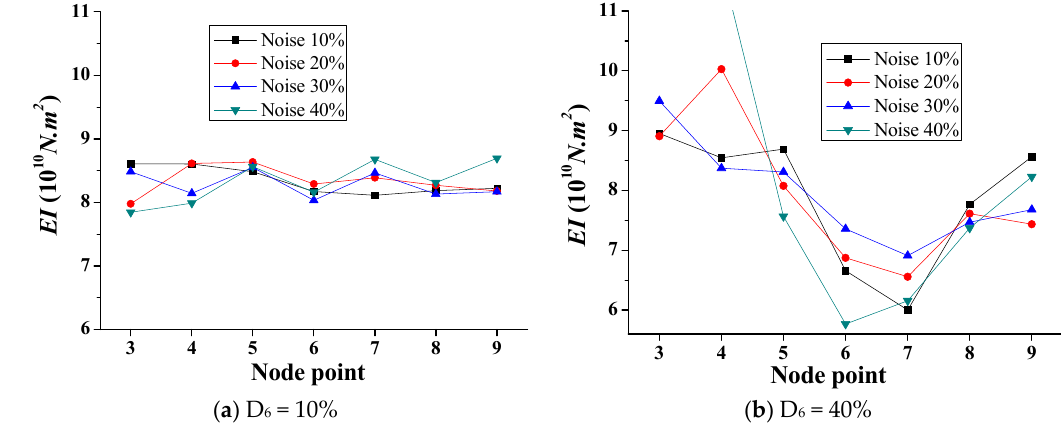
Figure 17. Simulation results of calculated EI with different noise levels (Scenario 1).